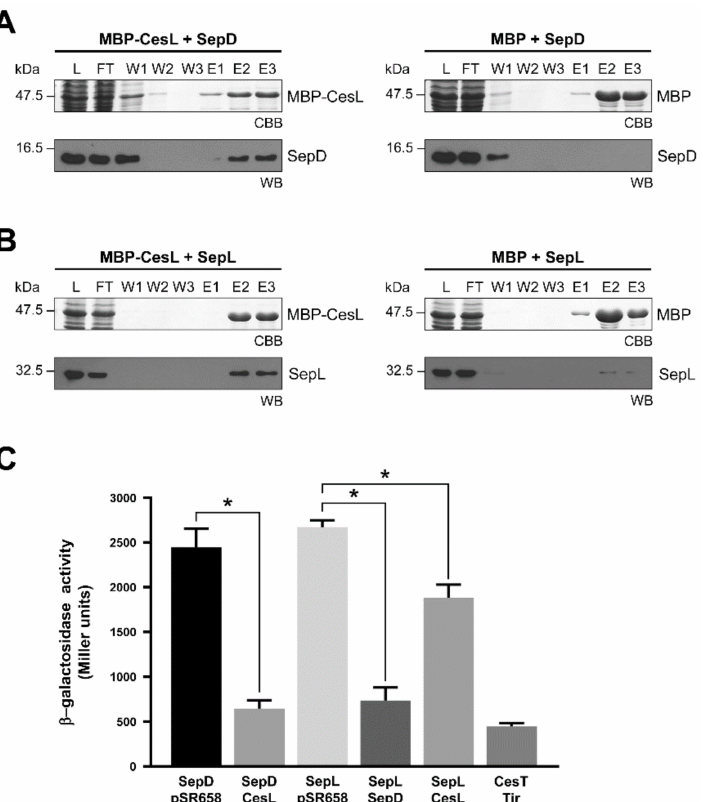
Figure 2. CesL associates independently with both SepD and SepL proteins. The MBP-CesL or MBP protein from a cleared cell lysate was immobilized on amylose resin and then a cleared lysate (L) containing either ( A ) untagged SepD or ( B ) untagged SepL was loaded onto the protein-coupled resin. Samples from the flow-through (FT), washes (W), and elutions (E) were collected and analyzed by CBB-stained SDS-PAGE and immunoblotting using anti-SepD or anti-SepL polyclonal antibodies. ( C ) Quantification of β -galactosidase activity of E. coli SU202 strain carrying plasmids pSR659 and pSR658 or derivatives thereof (expressing sepD , sepL , cesL , tir or cesT genes). The known SepD-SepL and CesT-Tir interactions were used as positive controls. Data represent the mean of three independent experiments in Miller units. Measurements were subjected to a 2-sided t-test to determine the statistical significance of the activity produced by the protein interactions compared to their respective negative control. * p <